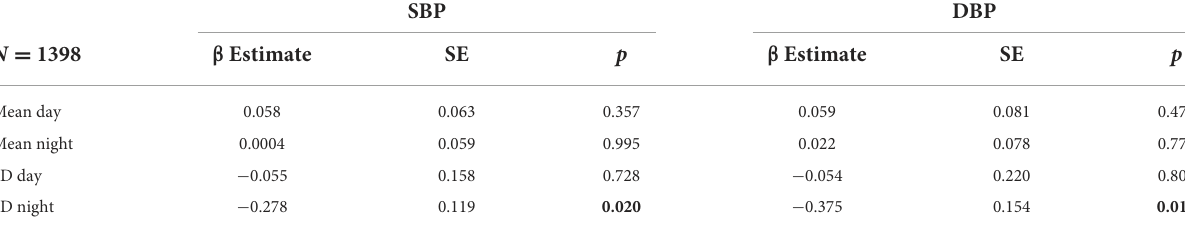
TABLE 2 Associations between 24-h BP indicators and total brain volume